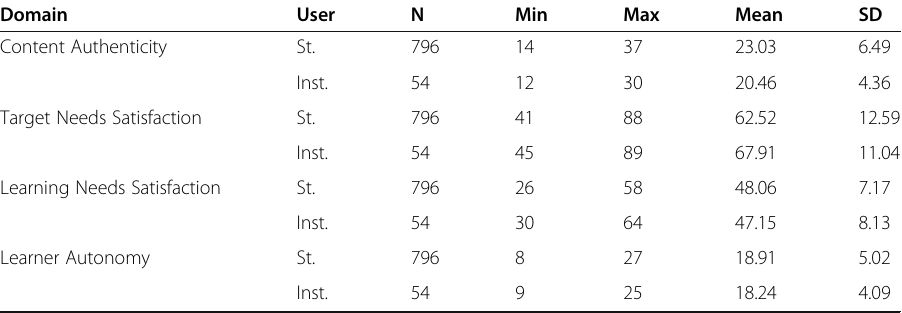
Table 5 Descriptive Statistics of the Attitude Scores Based on Different Course-Related Domains